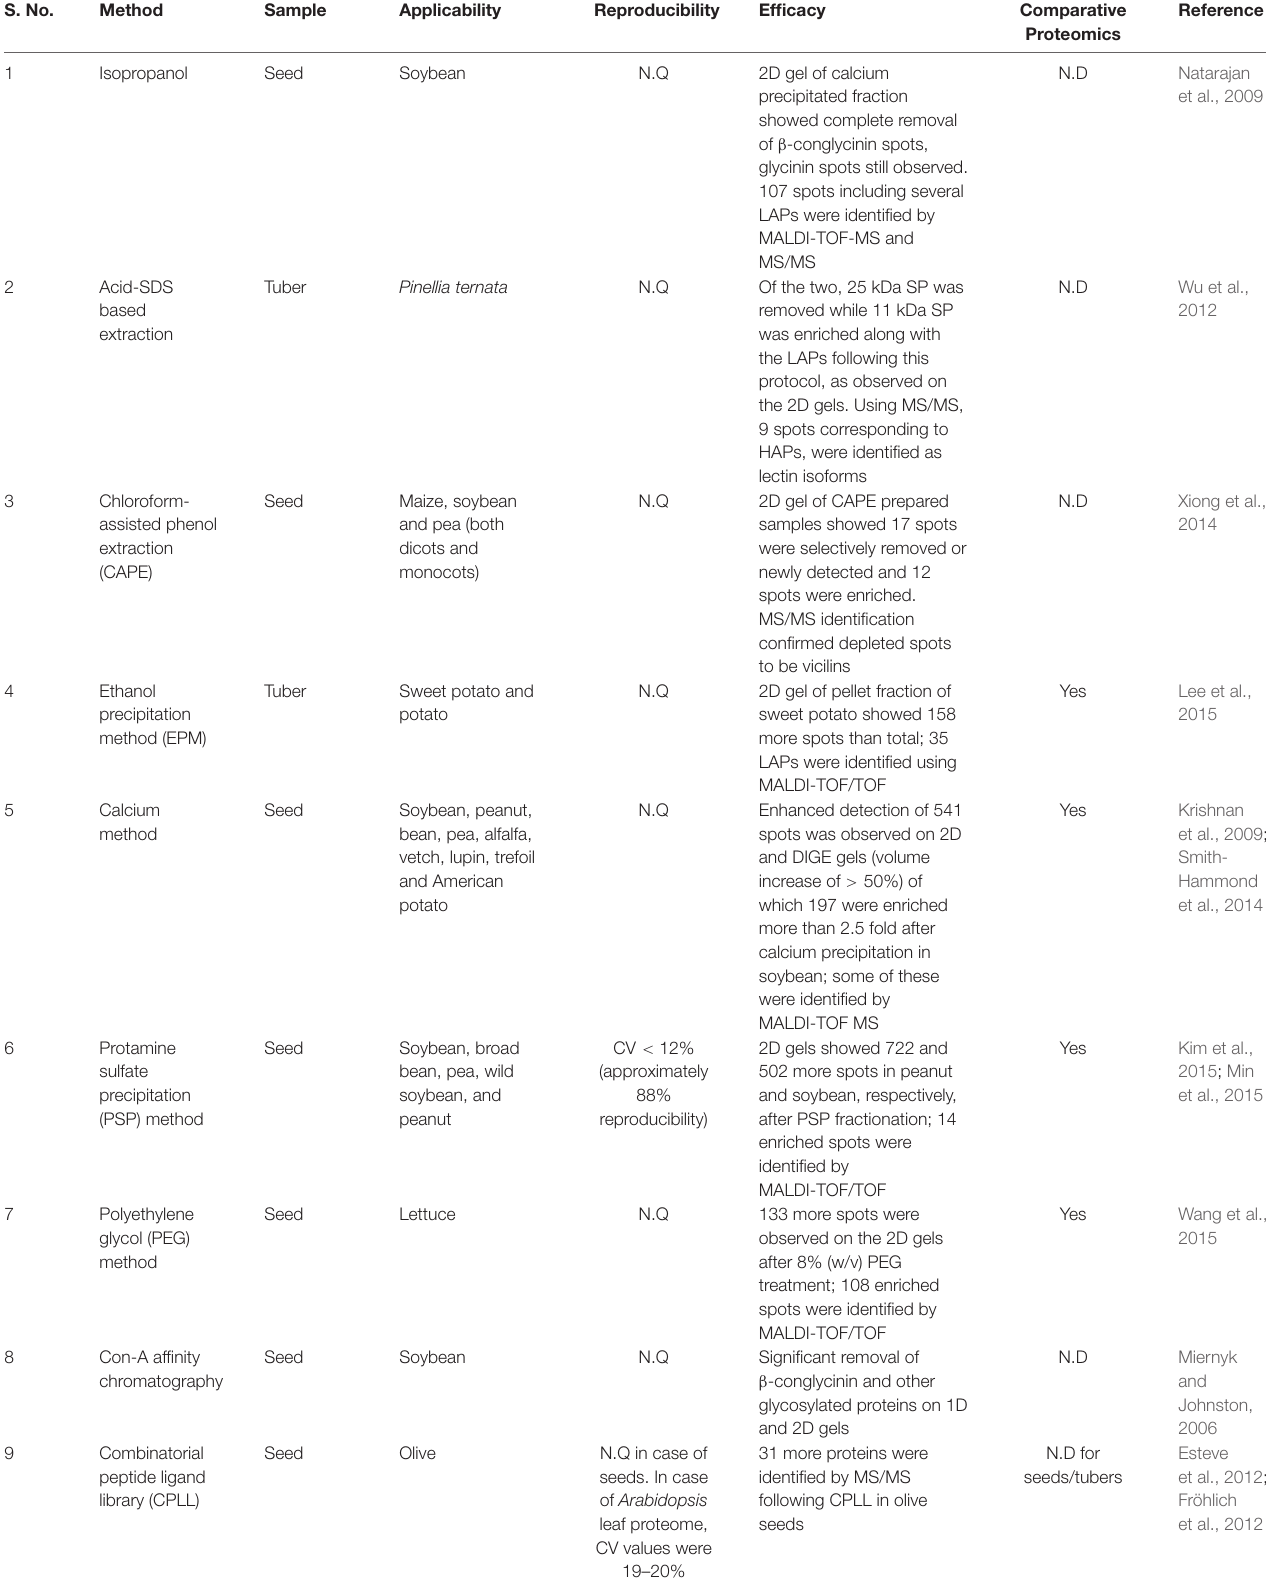
TABLE 1 | Comparative analysis of the available methods for the enrichment of low-abundance proteins (LAPs) from seeds and tubers. S.